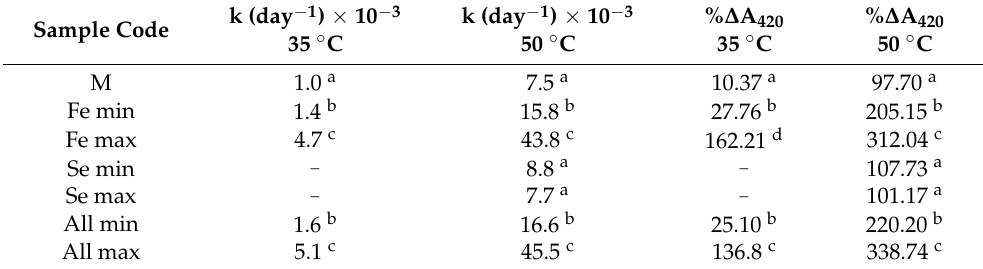
Table 2. Browning rate constants (k) and percentage changes in absorbance at 420 nm (A 420 ). Sample